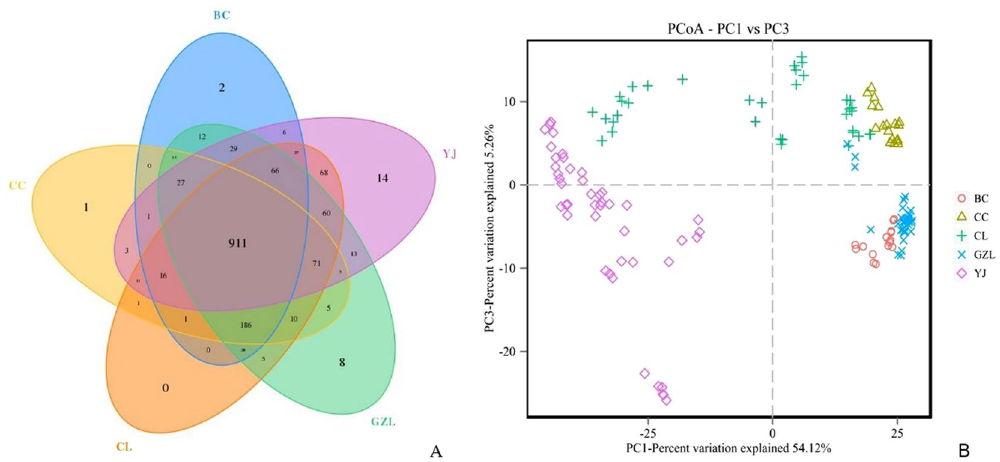
Figure 1. Differences in bacterial community diversity, richness and structures between different sheep farms. ( A ) Community diversity and richness between high and low weight feces (both hard and soft